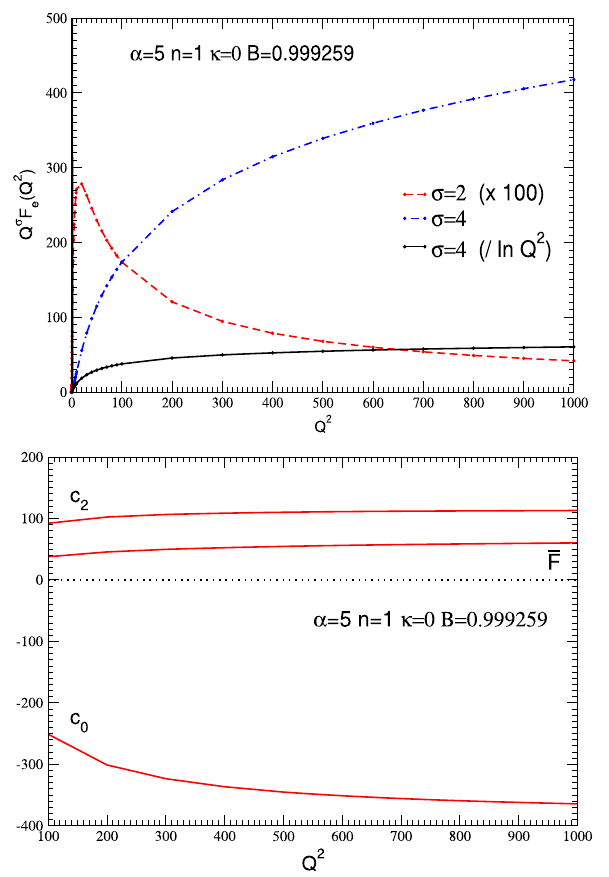
Fig. 13 Same as in Fig. 12, but for the n = 1 abnormal state No. 3 from Table